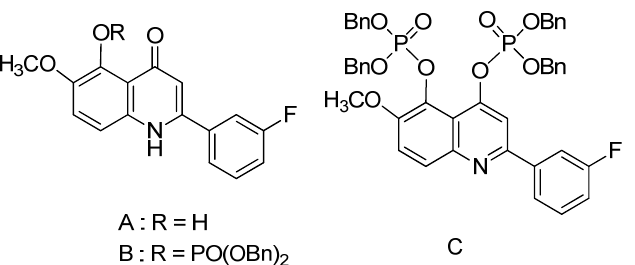
Figure 1. Structures of compounds A – C